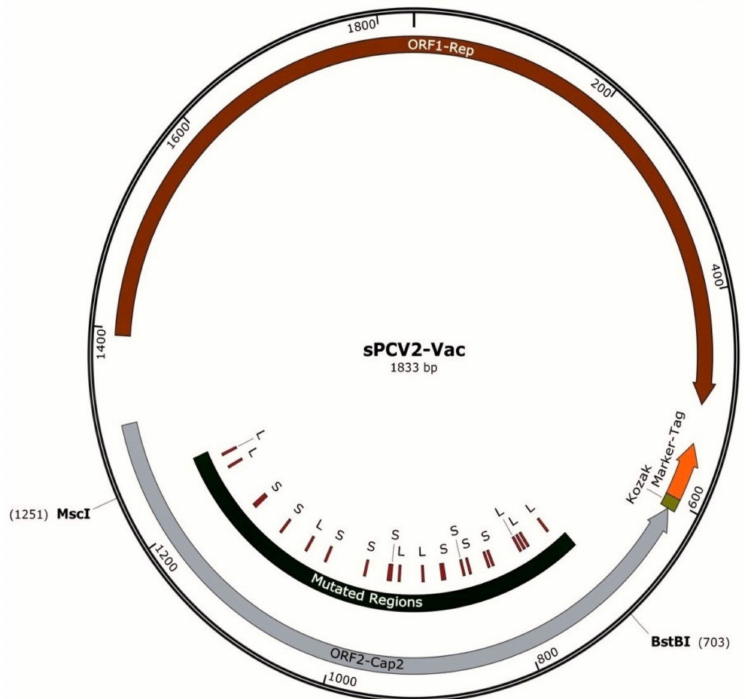
Figure 1. Map of the sPCV2-Vac construct: The PCV2b backbone is depicted as a circle, with the two major open reading frames indicated by counterclockwise block arrows. The transcriptional unit for the SRS2 epitope tag is shown at the 5 (cid:48) end of ORF2, which encodes the capsid protein. The location of the modified serine and leucine codons is indicated and flanked by the enzymes used for insertion into the